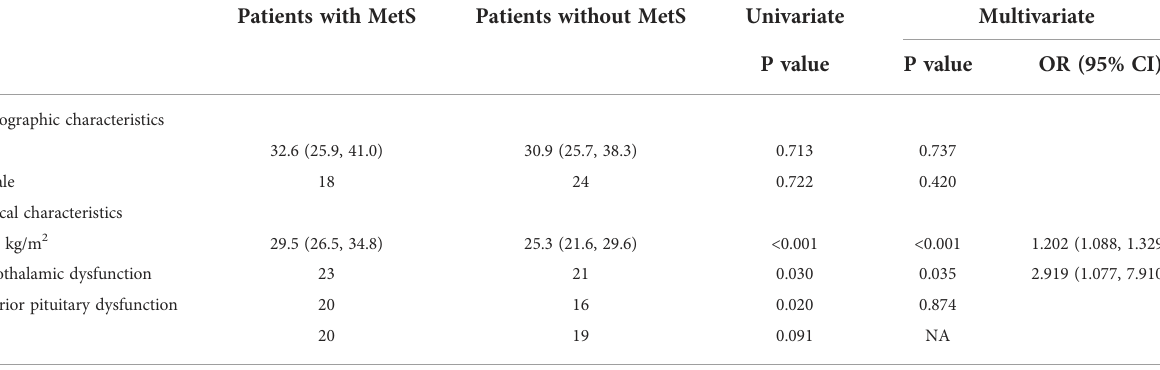
TABLE 7 Univariate and multivariate predictors of metabolic syndrome in adults with hypothalamic dysfunction and BMI-matched control. Patients with